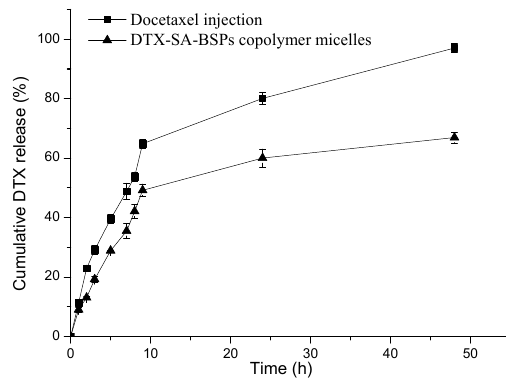
Figure 2. In vitro release profiles of DTX from docetaxel injection (- ■ -) and DTX-SA-BSPs copolymer micelles (- ▲ -) in pH 7.4 phosphate-buffered saline containing 0.2% Tween 80 at 37 ± 0.5 °C.